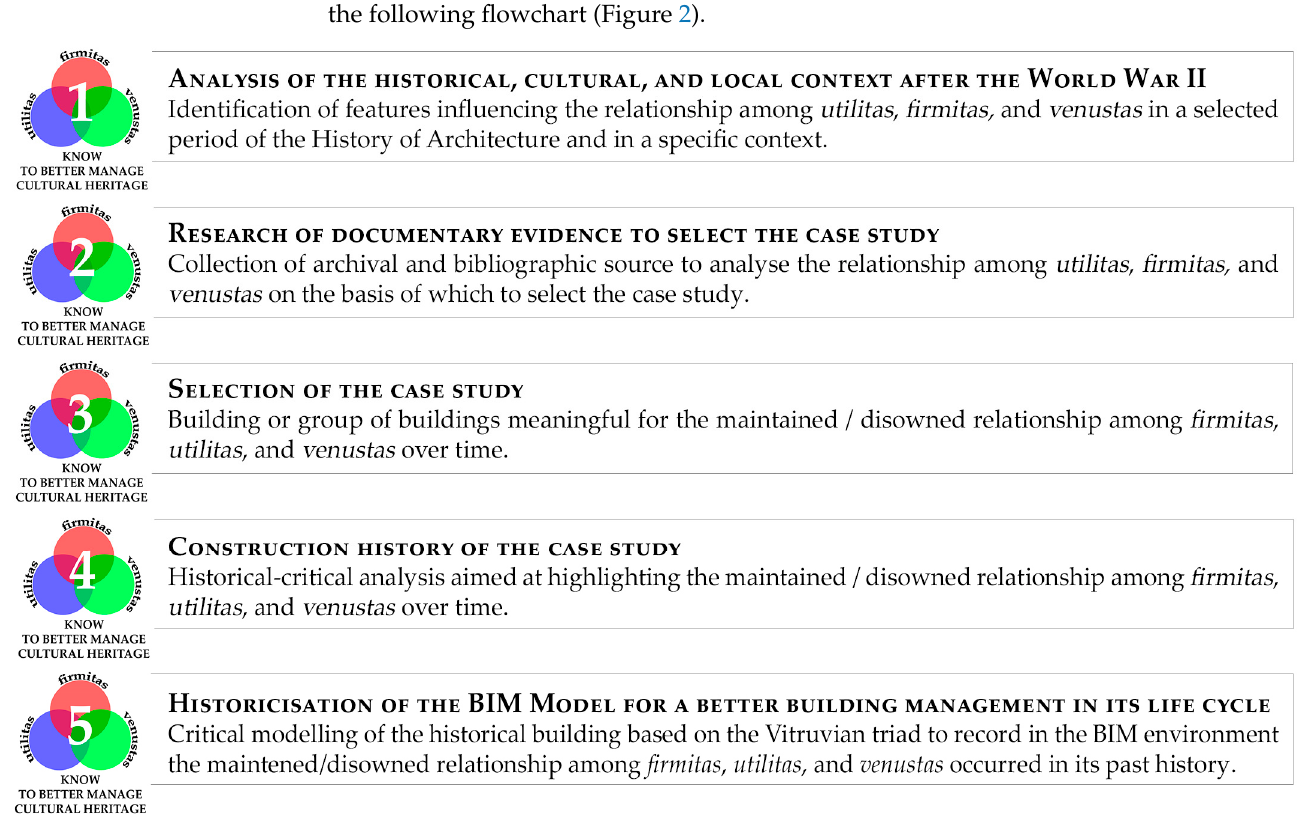
Figure 2. The methodological approach based on the Vitruvian triad for a more conscious digitalisation of the cultural heritage.